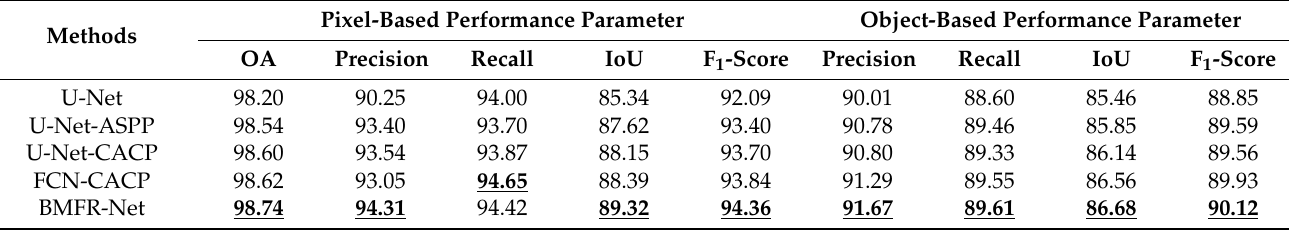
Table 4. Quantitative evaluation (%) of U-Net with different multiscale feature extractions and fusion modules. The best metric value is highlighted in bold and